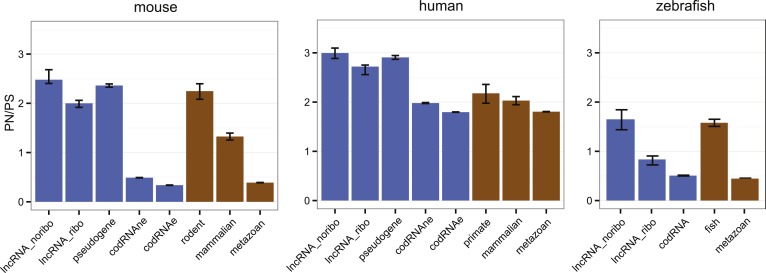
Selective pressure in ORFs from different types of transcripts.PN/PS: ratio between the number of non-synonymous and synonymous single nucleotide polymorphisms (SNPs) in the complete set of primary ORFs for a given class of transcripts (in lncRNA_noribo the longest ORF was considered). In blue, data for different coding and non-coding transcript classes. In brown, data for different age codRNA classes. The bars represent the 95% confidence interval for the PN/PS value. For the species not shown there was not sufficient data to perform this analysis.